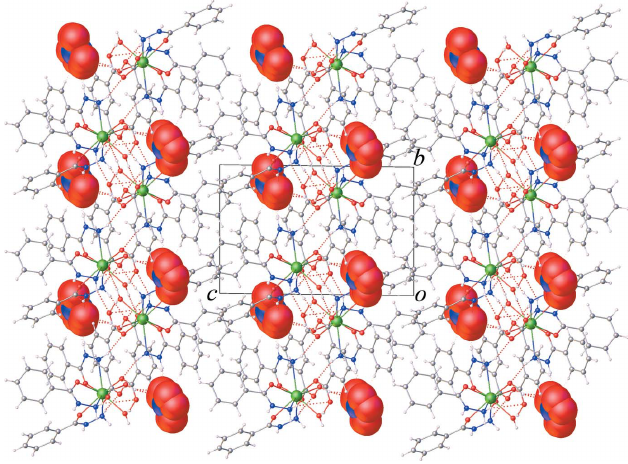
Figure 5 The crystal packing of the title compound, viewed along the a axis. The nitrate molecules are shown with a space-filling